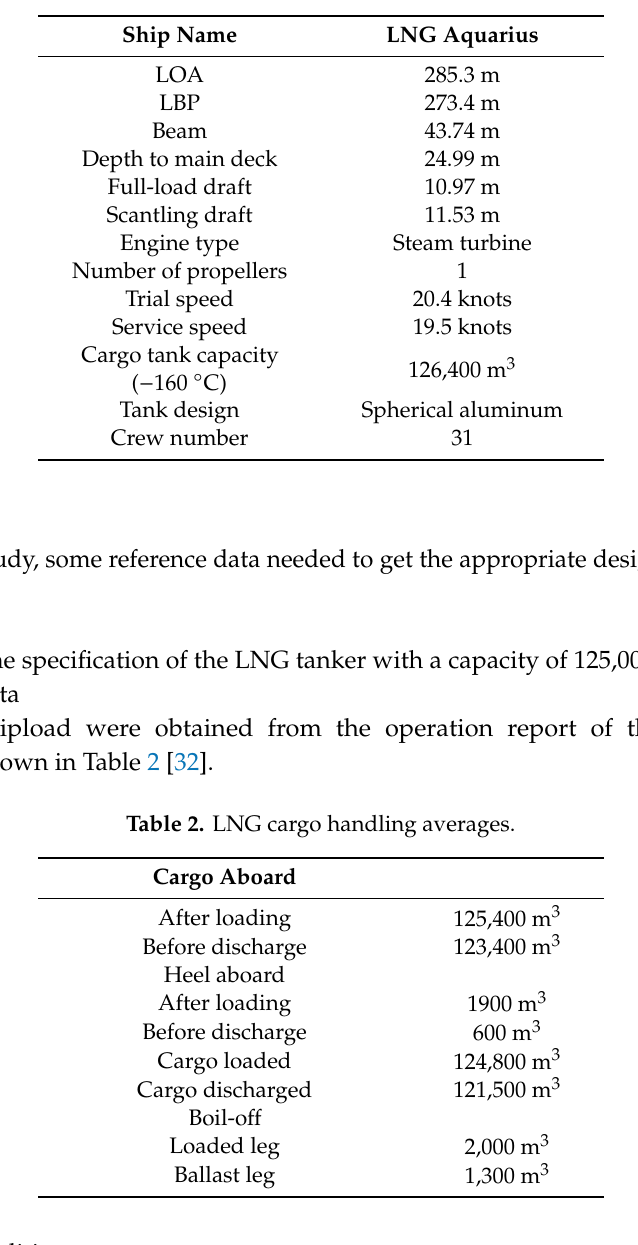
Table 1. LNG tankers with a capacity of 125,000 m 3 .